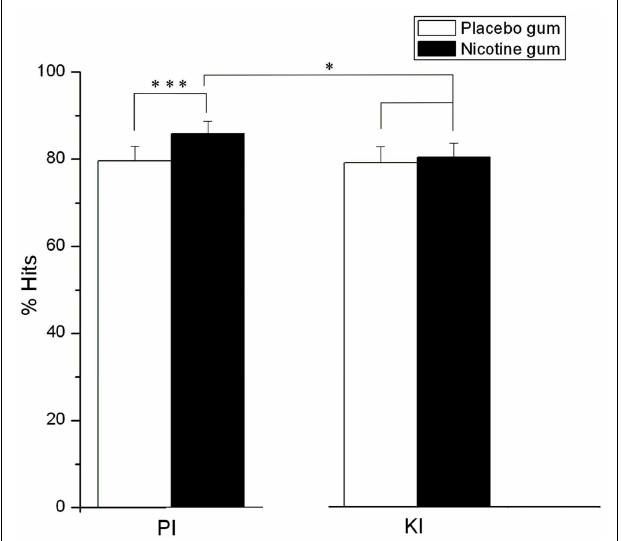
FIGURE 4 | Effects of placebo and nicotine gum (collapsed across time blocks, and L-HD and H-HD groups) on mean ( ± SE)% hits during placebo (PI) and ketamine (KI) infusion (* p < 0.05; *** p < 0.001) .